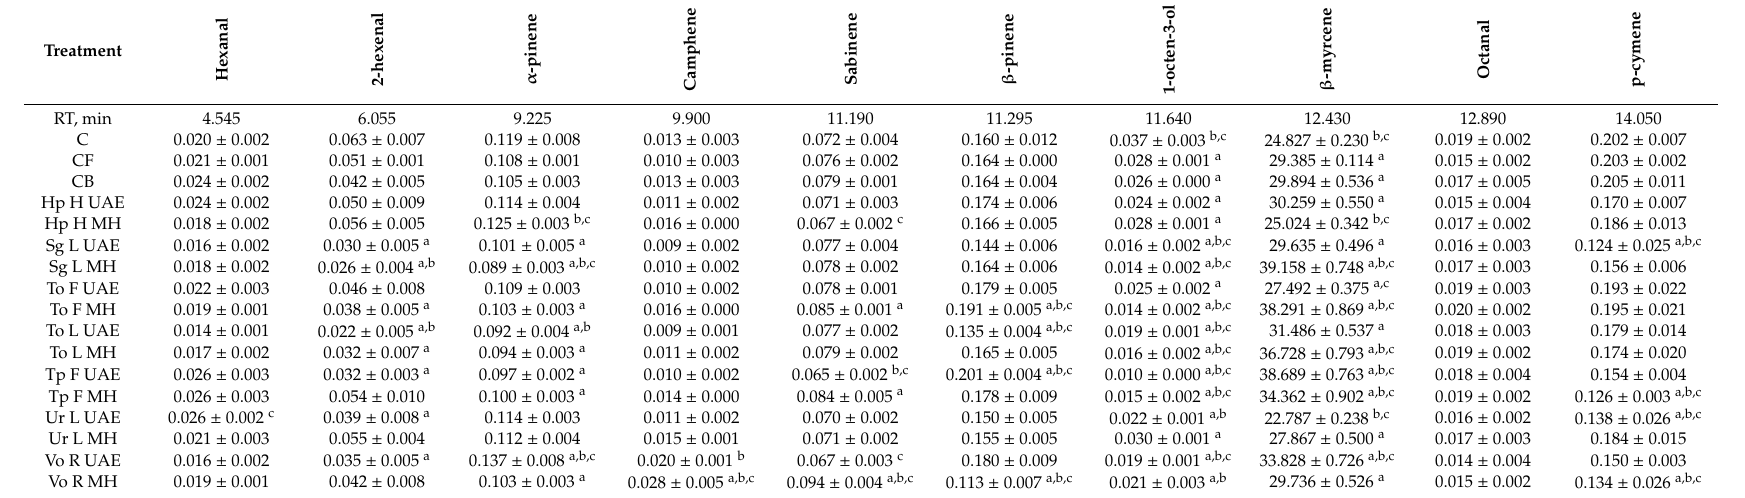
Table 5. E ff ect of the foliar application of botanical extracts on the volatile compounds profile (amount of single component calculated as percent (%) of whole GC-MS chromatogram area) of celeriac leaves (N = 3, mean ±